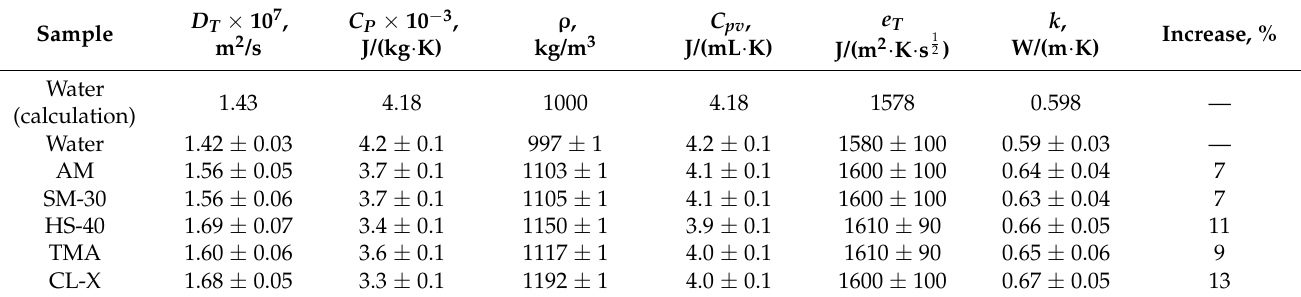
Table 3. Experimental values of thermophysical parameters by thermal-lens spectrometry ( n = 3, p = 0.95) and calculated values for colloidal silicon oxide solutions, AM ( ω (SiO 2 ), 18% w / w ), SM-30 ( ω (SiO 2 ), 17.5% w / w ), CL-X ( ω (SiO 2 ), 26.5% w / w ), TMA ( ω (SiO 2 ), 20% w / w ), and HS-40 ( ω (SiO 2